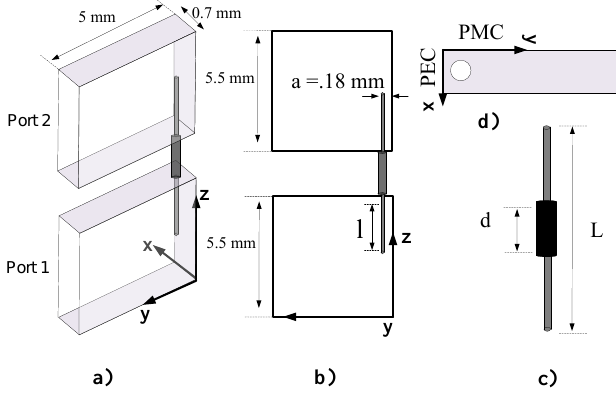
Fig.1. (a) Waveguides couples through cylindrical channel, shaded area represents PEC boundaries and unshaded area represents PMC boundaries (b) side view; (c ) metallic wire and channel between waveguides; (d) top View, location of